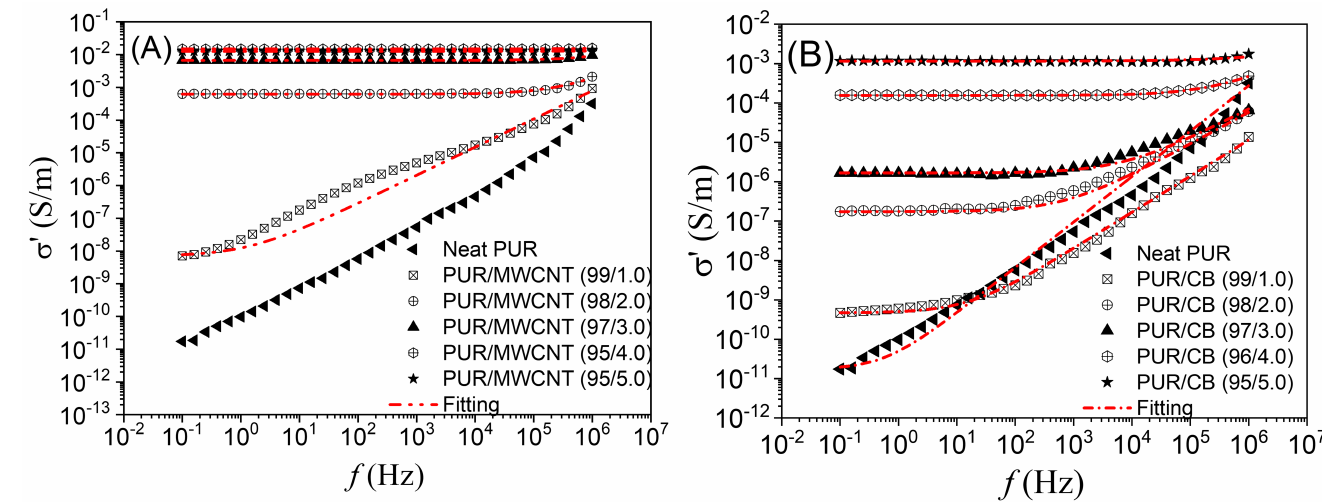
Figure 4. Real part of complex electrical conductivity as a function of frequency for ( A ) PUR/MWCNT and ( B ) PUR/CB with different mass fractions of the conductive